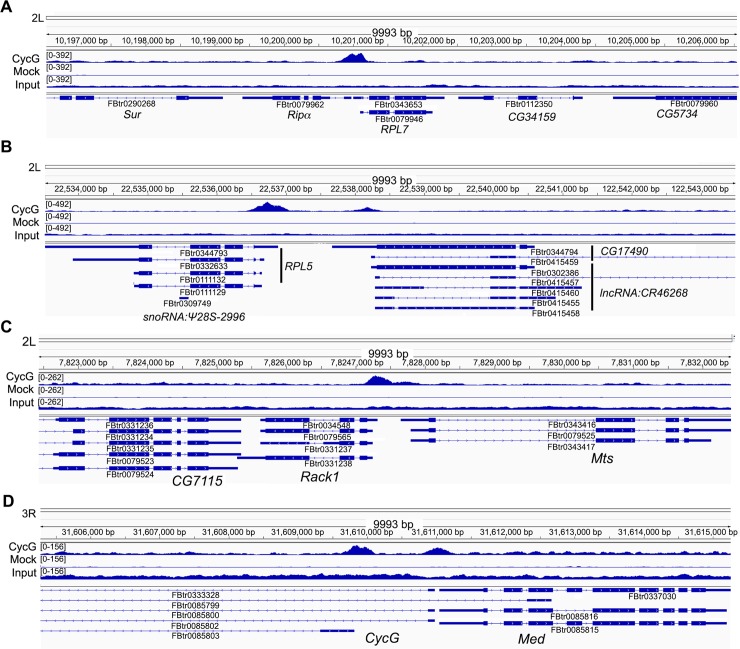
Snapshots illustrated Cyclin G ChIP-seq.Focus on RPL7 (A), RPL5 (B),
Rack1 (C) and CycG (D).